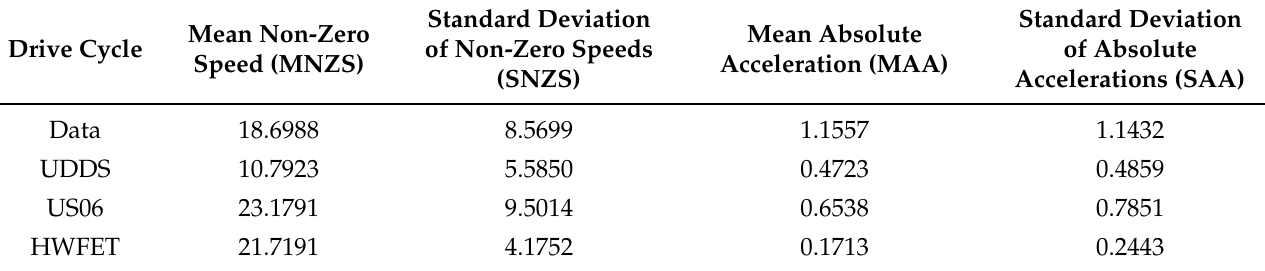
Table 2. Drive cycle characteristics for data drive cycle and EPA drive cycles Standard Deviation Mean Non-Zero Drive Cycle of Non-Zero Speeds Speed (MNZS) Data